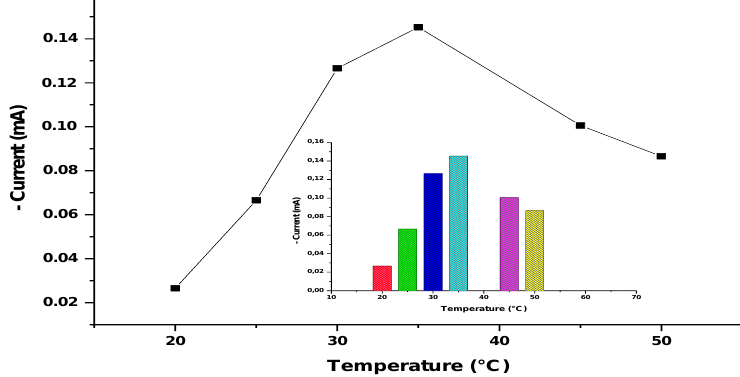
Figure 10. The effect of temperature on the biosensor response. [Working conditions; phosphate buffer, 50 mM and pH = 7.4, 5 mg/mL amlodipine solution].